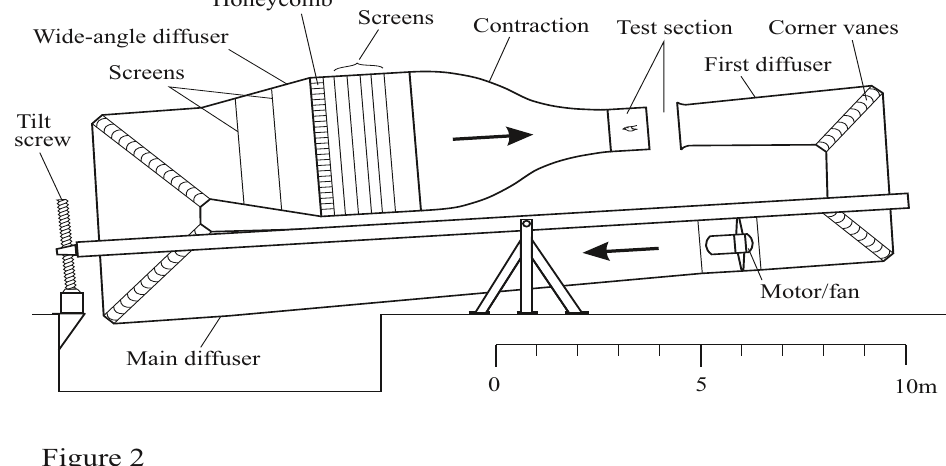
Figure 2. The Lund wind tunnel, installed in 1994, has a test section measuring 1.20 × 1.08 m and a contraction ratio of 12.25. There is a honeycomb, 5 screens and a fine wire